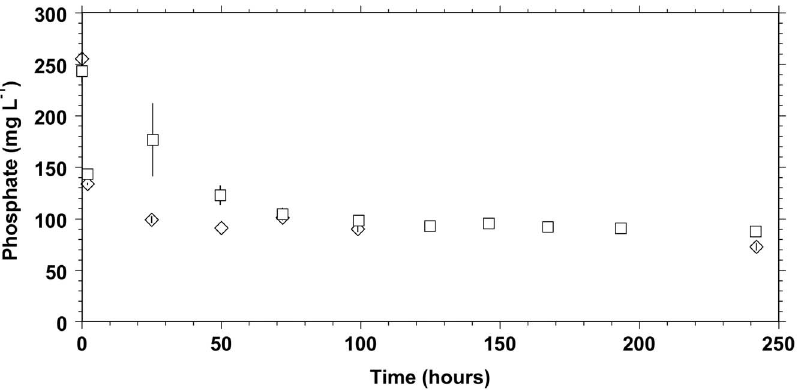
Figure 1. Change with time of dissolved total phosphate concentration in the sterile (dash) and inoculated (triangle) DSMZ medium after complementation with NaHCO 3 (at time 0).